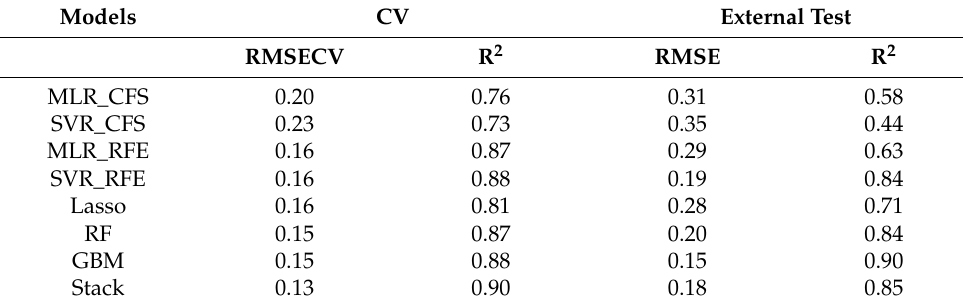
Table 4. Prediction performances of all models at pH 6.5.